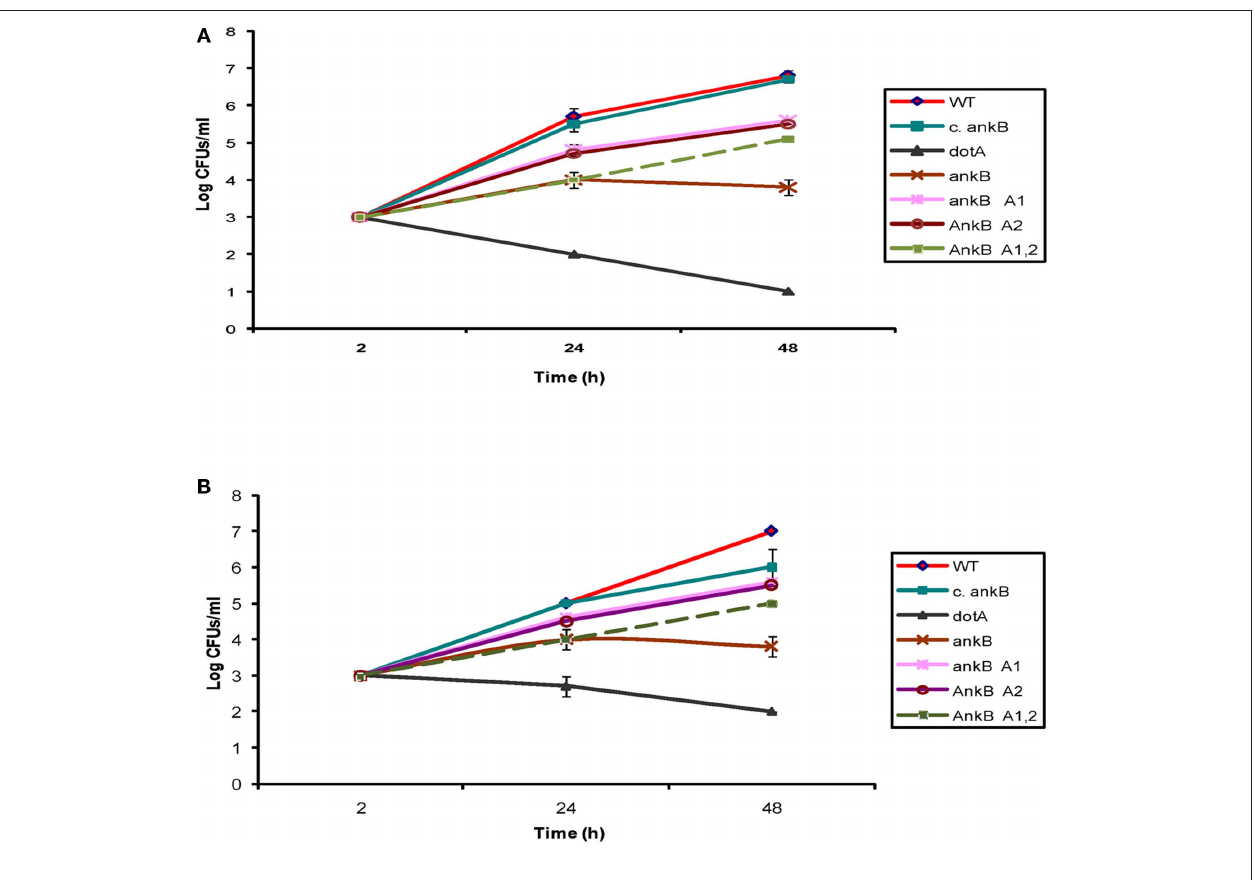
FIguRe 7 | The two ANK domains of AnkB are essential for the biological function of AnkB in intracellular growth of L. pneumophila in D. discoideum . (A) D. discoideum or (B) A. polyphaga were infected with the WT strain, the ankB mutant, or the ankB mutant harboring one of the mutant alleles ankB ∆ A1, ankB ∆ A2, or ankB ∆ A1A2. The ankB mutant complemented